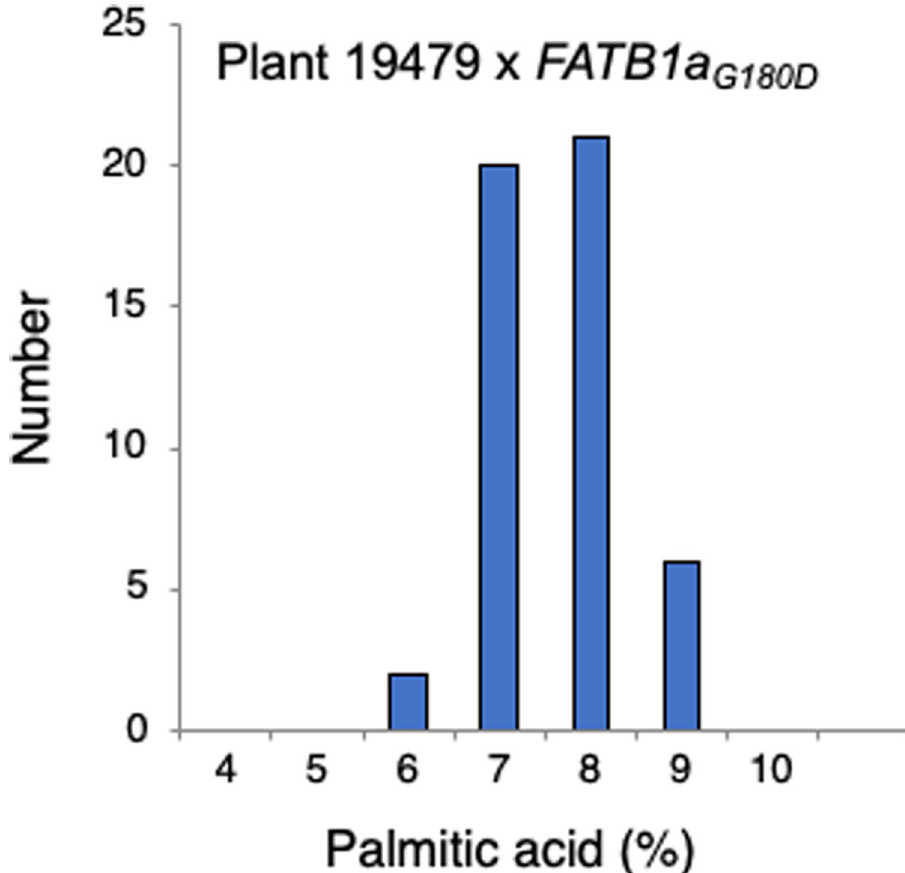
. Fatty acid content was G180D